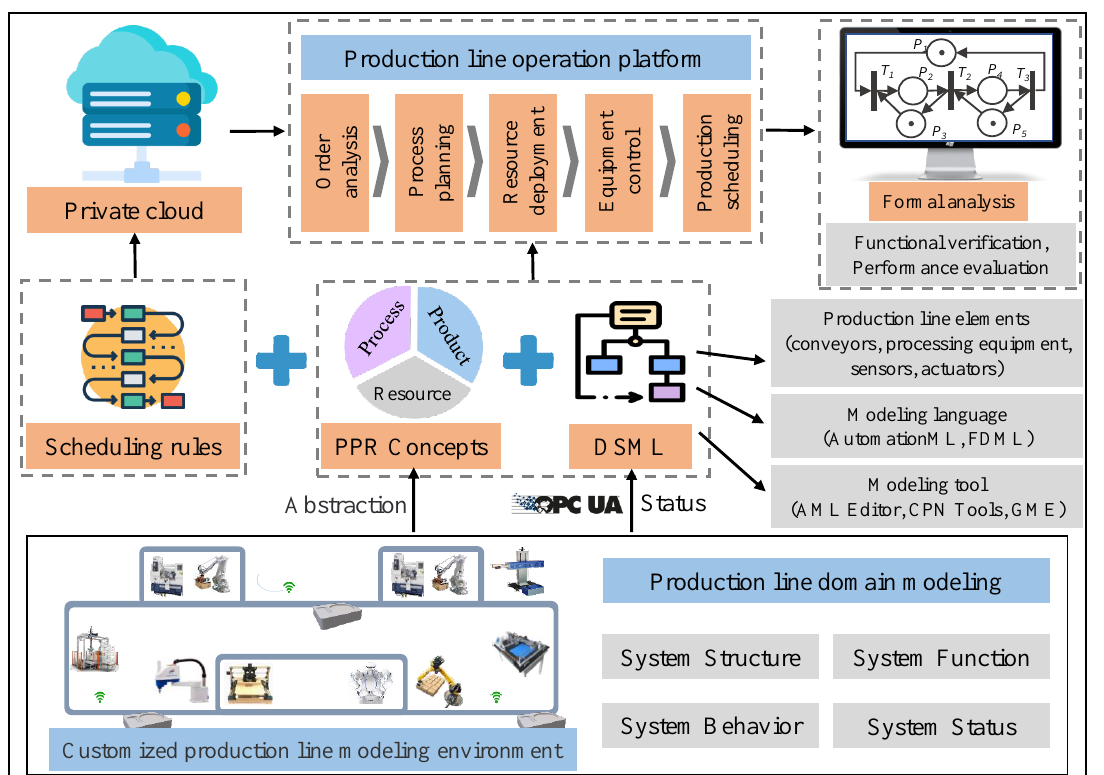
Figure 1. Framework of componentized formal method